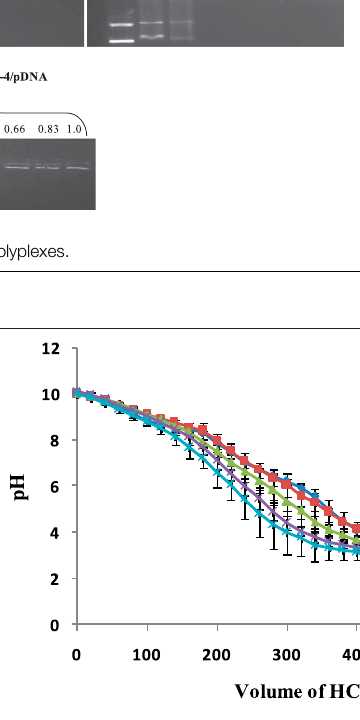
FIGURE 3 | Buffering capacity of lPEI and LP-PTMG polymers.